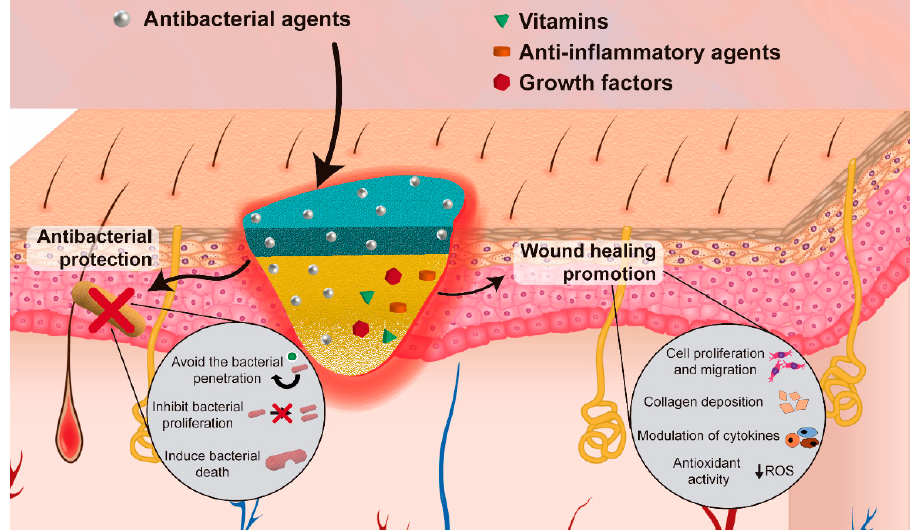
Figure 4. Illustration of the incorporation of bioactive agents to improve the antibacterial efficacy and/or enhance the wound healing process. and/or enhance the wound healing